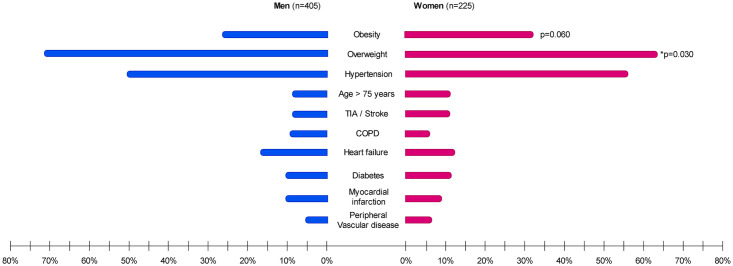
Sex-differences in clinical characteristics.Results of Chi-squared test p < 0.1 are given. The asterisk (*) indicates statistical significance (p < 0.05). Abbreviations: COPD = chronic obstructive pulmonary disease, TIA = transient ischemic attack.